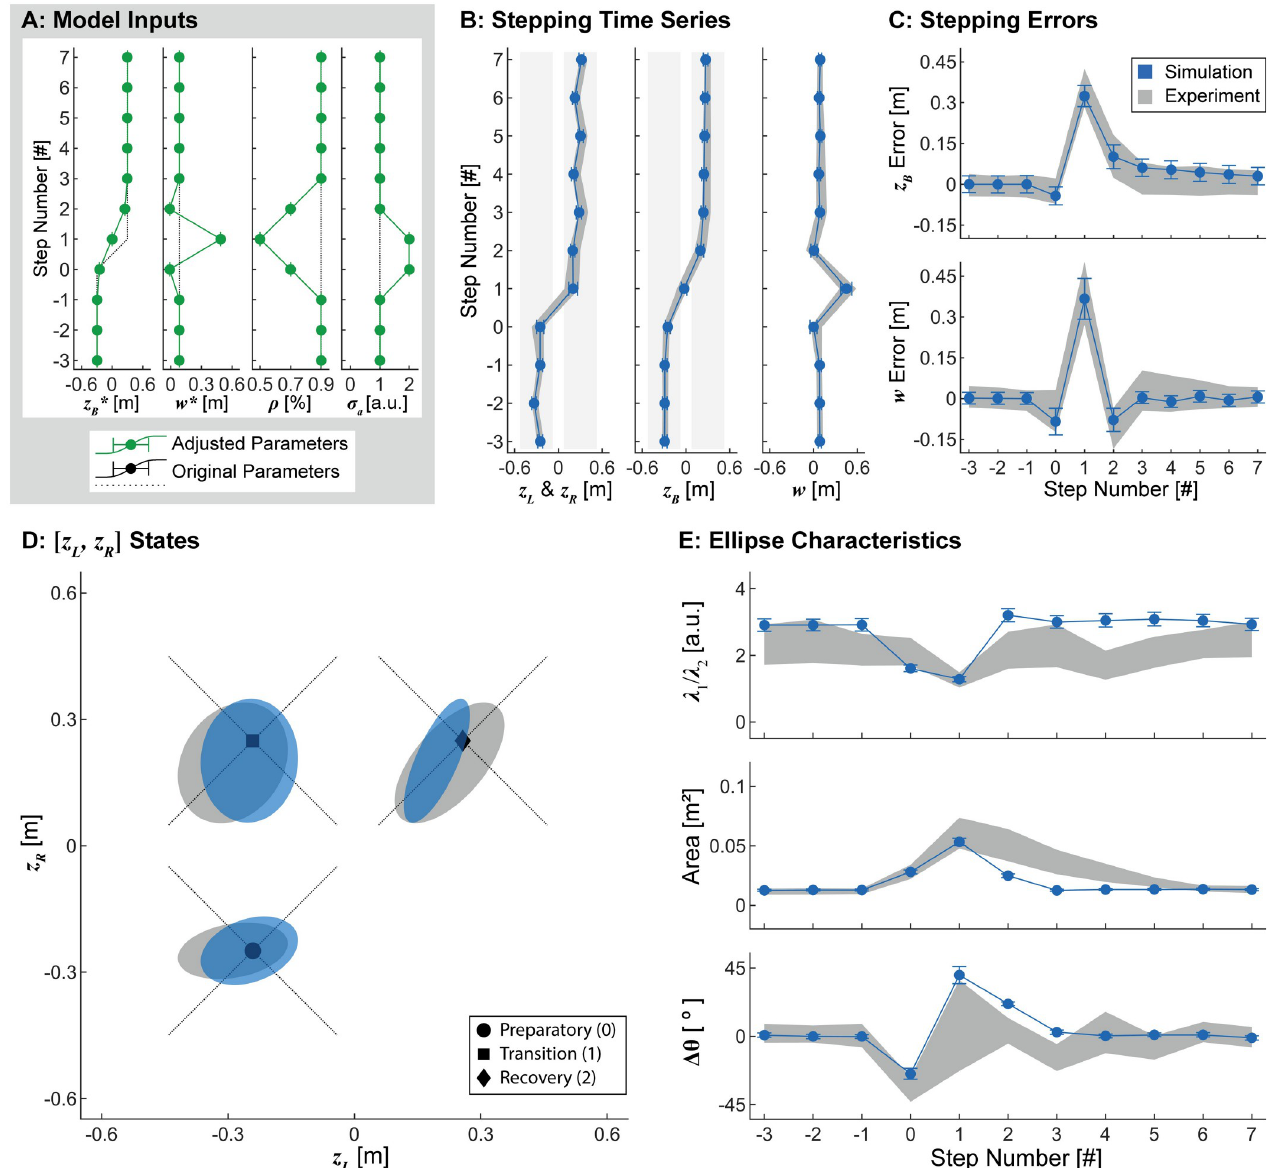
Fig 8. Adaptive Additive Noise. A) Model parameters. Here, in addition to adapting the stepping goals (Fig 6) and ρ (Fig 7), additive noise ( σ a ) was also doubled at the preparatory and transition steps. B-E) Results obtained from 1000 simulated lateral transitions using the parameters in (A), with data plotted in an identical manner to Figs 6 and 7. Adding σ a modulation again emulated experimental stepping time series and errors (B-C), as well as the qualitative changes in the aspect ratio of the fitted ellipses during the maneuver (D-E). Furthermore, modulating σ emulated the experimentally observed increases in a ellipse areas. Modulating σ a also affected orientations of the fitted ellipses, although not entirely in the same ways as the experimental data (D-E). Therefore, � , w � ]), control proportion ( ρ ), and additive noise ( σ ) in our existing model can elicit changes in stepping adaptively modulating the stepping goals ([ z B a dynamics qualitatively similar to those observed in humans during this lateral